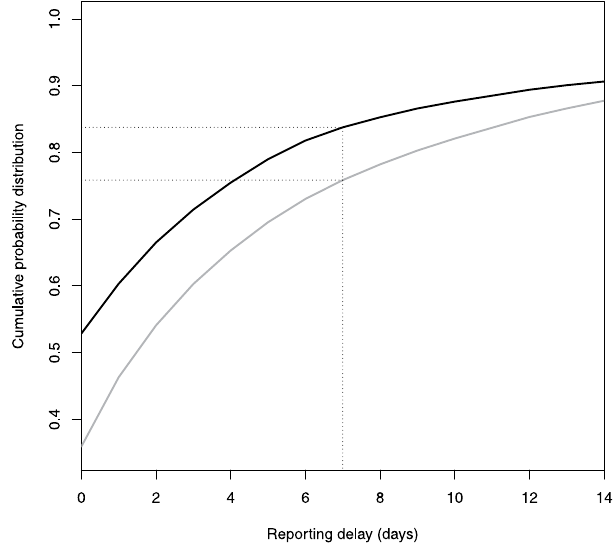
Figure 1. Cumulative probability distribution of the reporting delays for on-farm deaths (black) and perinatal deaths (grey) in the TVD. Over 80% of on-farm deaths and over 70% of perinatal deaths were reported within seven days of occurrence (dotted lines). We focused on reports with relatively short reporting delays ( ≤ 14 days) which are the most relevant for timely outbreak